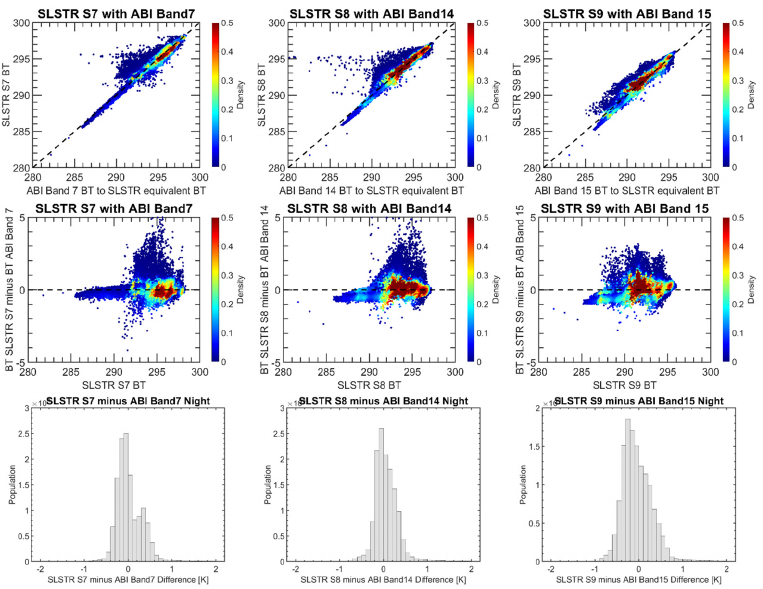
Figure 8. As shown in Figure 5, but for nighttime.